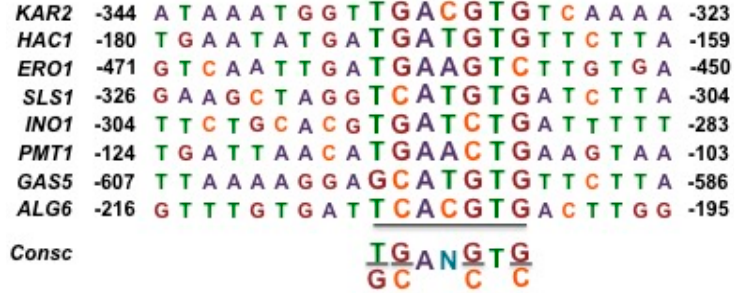
Figure 8. Blast search of the putative K. lactis UPRE motif (shown in brown in Figure 7) in putative ER stress-responsive genes. The search was directed to the indicated 5 ′ untranslated regions of the indicated genes. Coordinates are relative to the first nucleotide of the respective translation start codon.